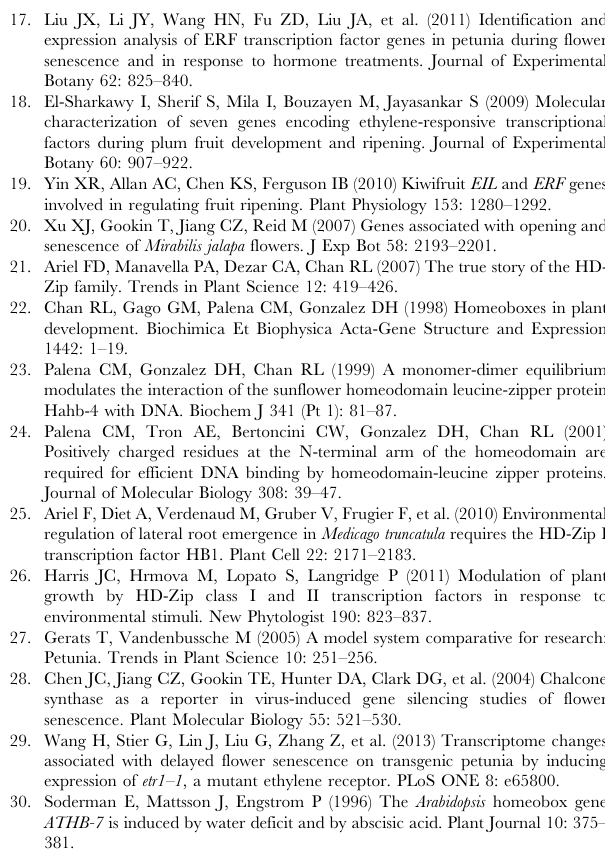
Table S1 Occurrence of the listed cis-elements in the 1.5 Kb upstream promoter regions of petunia ACS and ACO genes. Table S2 Primers used for semi-quantitative